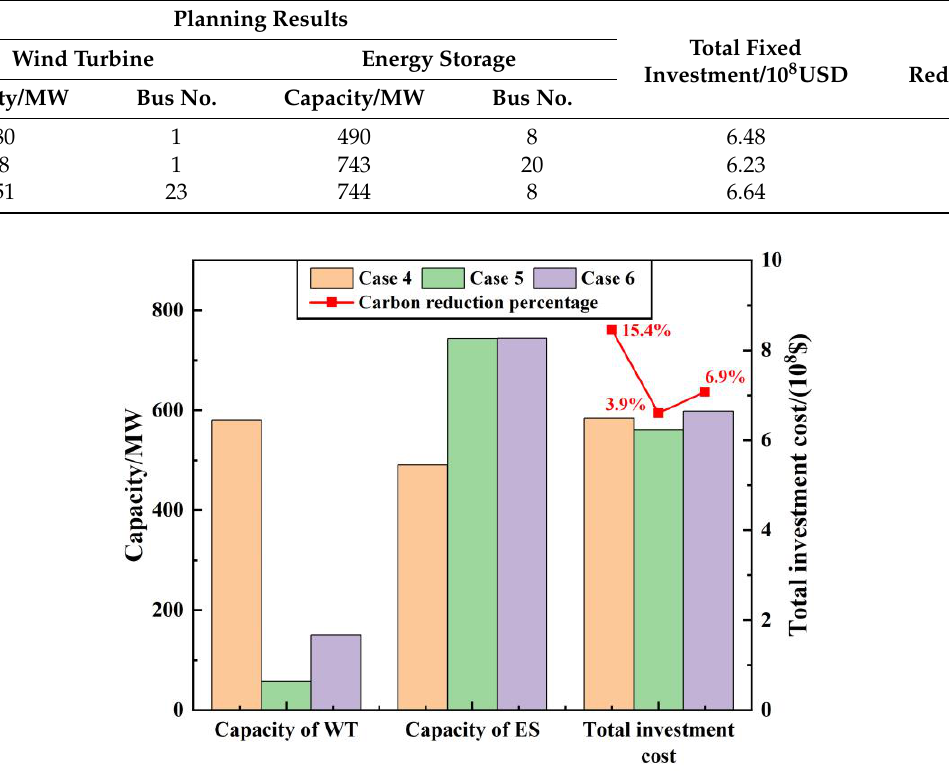
Figure 10. Planning results of different cases in Scenario 2.